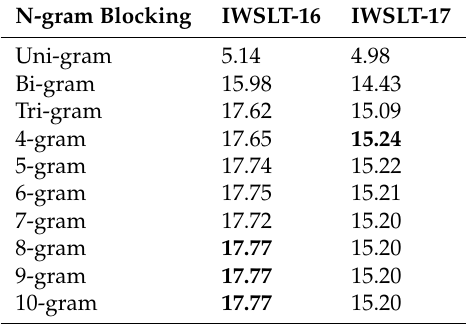
Table 5. Experimental results according to N-gram blocking.